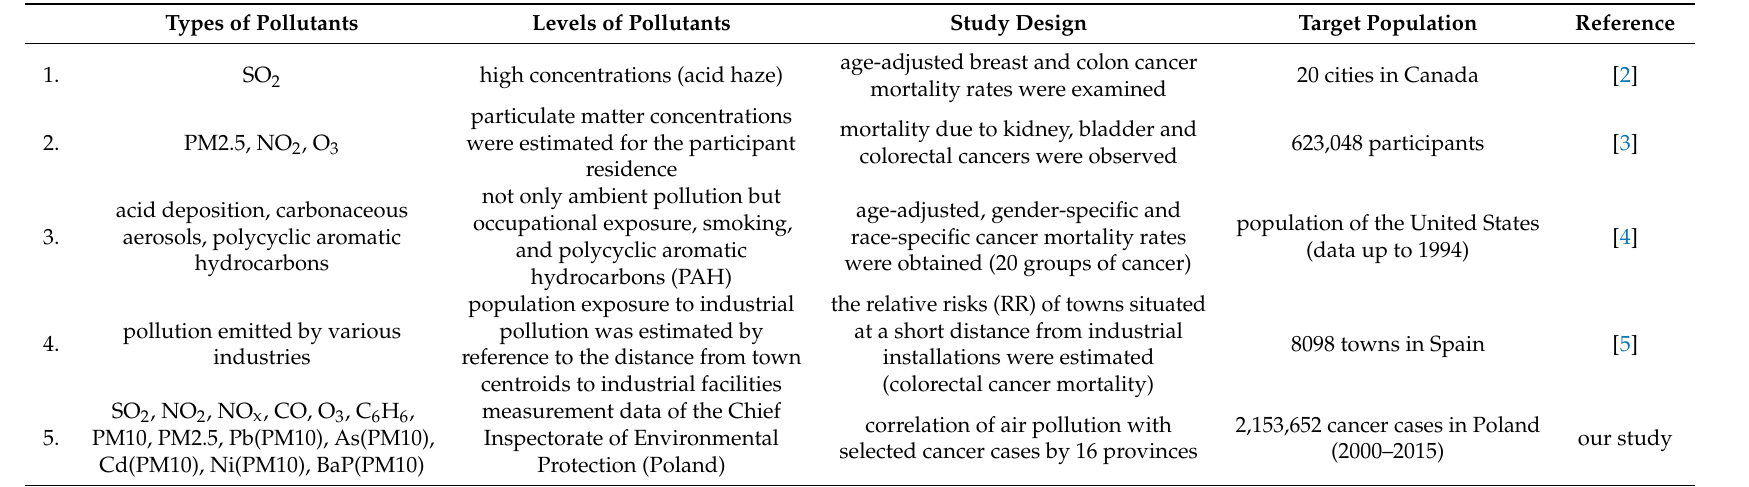
Table 1. A table summarizing the past literature including types of pollutants studied, levels of pollutants, study designs and target population as compared to the data in the current study. PM: particulate